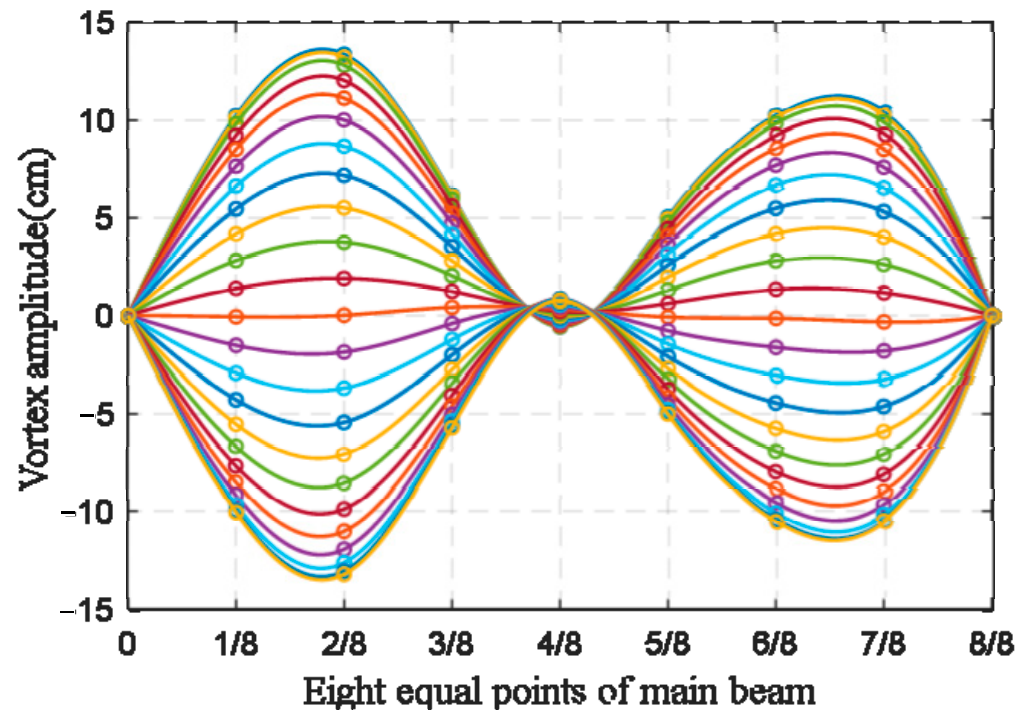
Figure 9. Real-time dynamic configurations of the main beam experiencing VVIV at different times. Each color represents a different moment from the peak of the wave to the trough of the